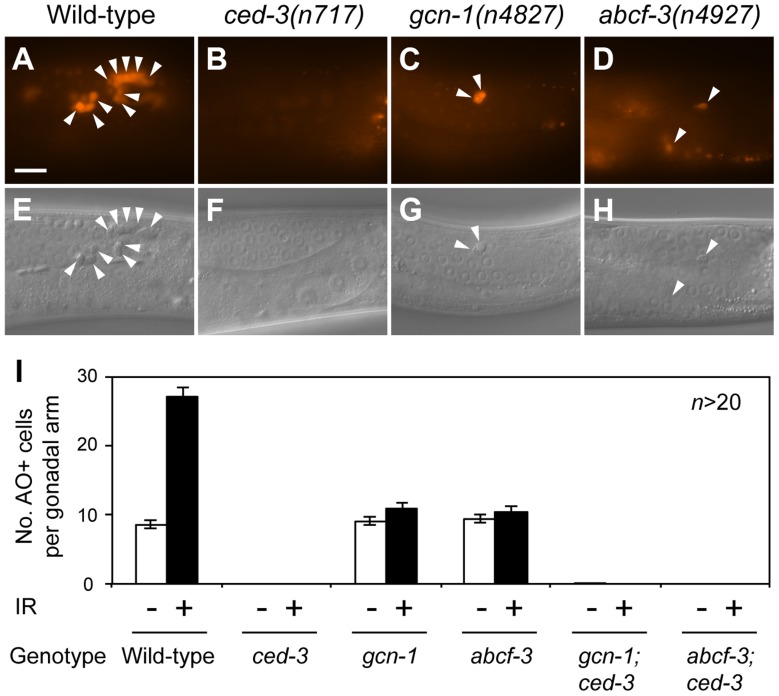

gcn-1(n4827) and abcf-3(n4927) cause a defect in radiation-induced germline cell death.(A–D) Acridine orange (AO) staining of apoptotic germ cells in the posterior gonads of animals of the indicated genotypes. Arrowheads, AO-positive apoptotic germ cells. Scale bar, 10 µm. (E–H) Nomarski DIC images corresponding to A–D. Arrowheads, refractile apoptotic cells. (I) Numbers of AO-positive apoptotic germ cells in the posterior gonads of animals of the indicated genotypes. White bars, means and standard errors of the means without ionizing radiation (IR). Black bars, means and standard errors of the means with IR.